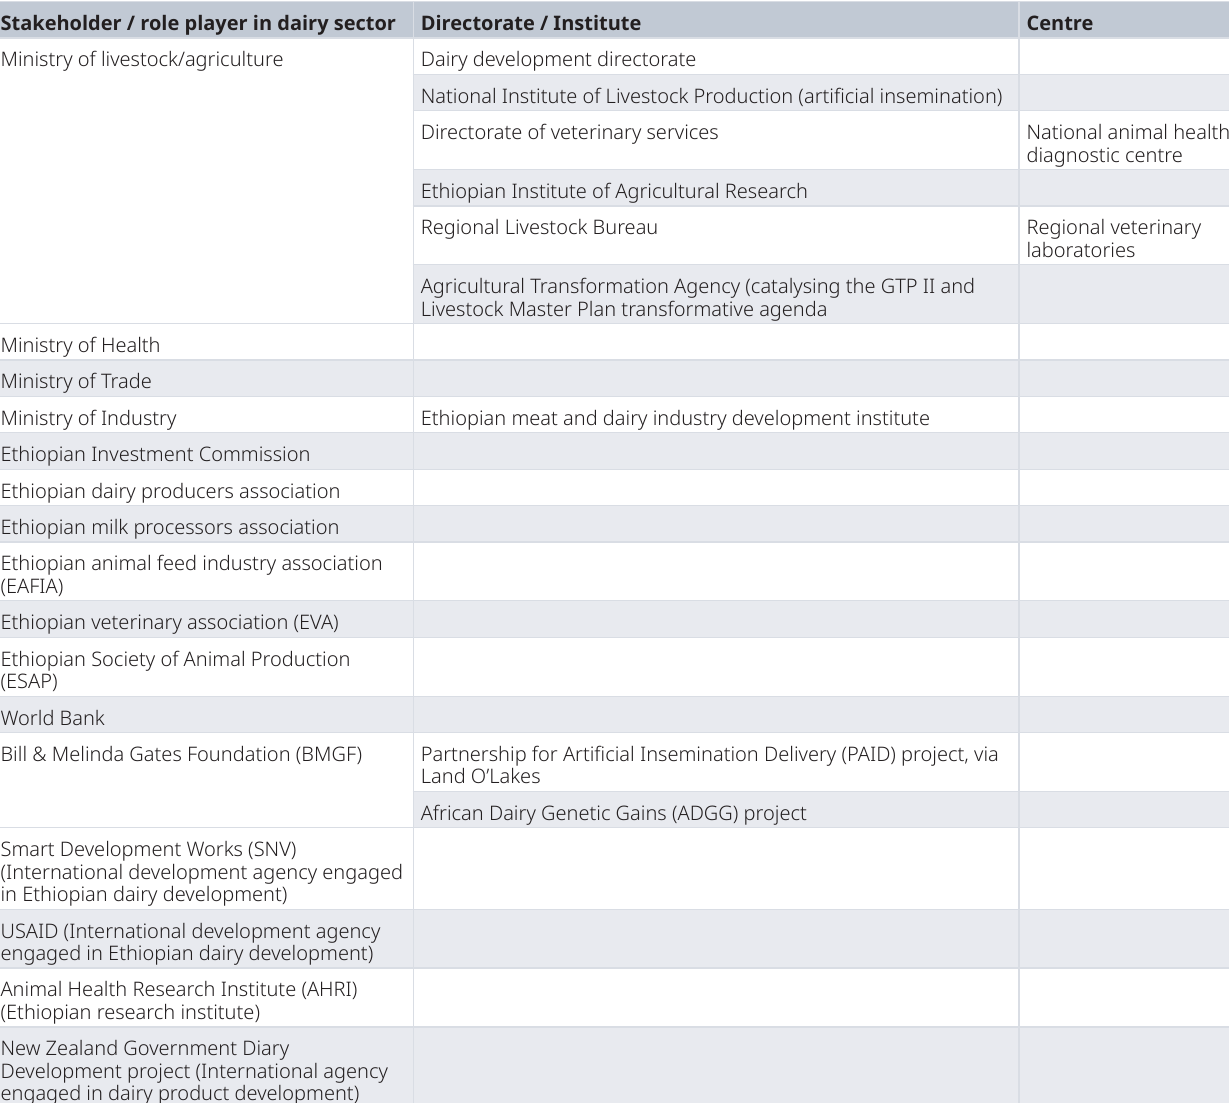
Table 2. Summary of institutions and stakeholders in the dairy